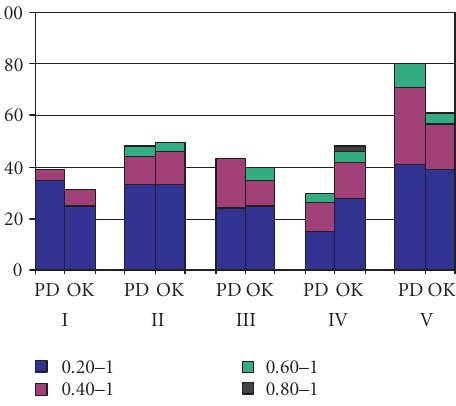
Figure 1: Individuals have assigned membership scores in the groups. These continuous scores ranging from 0 to 1 have been categorized as < 0 . 20, 0 . 20–0 . 39, 0 . 40–0 . 59, 0 . 60–0 . 79, and 0 . 80 to 1 . 00. Control subjects in each age group have similar frequency distributions of membership. Case subjects < age 60 over-represent membership in groups II and III, group IV at ages 60 to 69. Cases at age 70 and older over-represent the groups I and